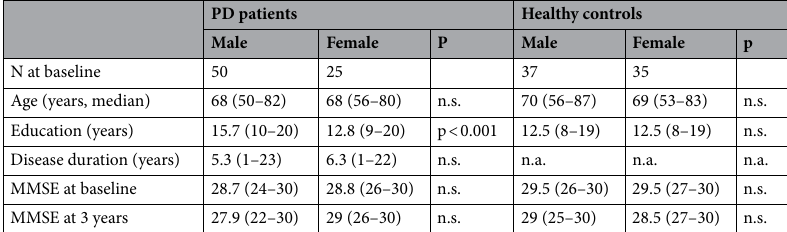
Table 1. Patients and healthy controls characteristics at baseline. Age, education, disease duration in years (median and range), paired